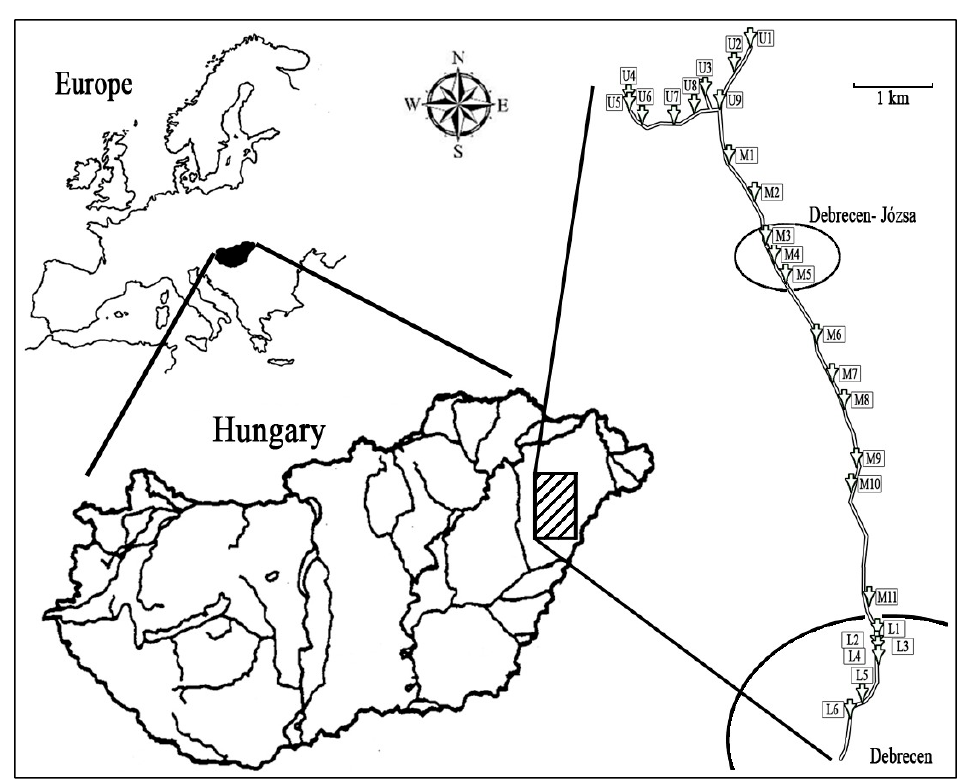
Figure 1. Sampling area of the small watercourse and its sampling points. Upper Area: U1 − U9; Middle Area: M1 − M11; Lower Area: L1 − L6.